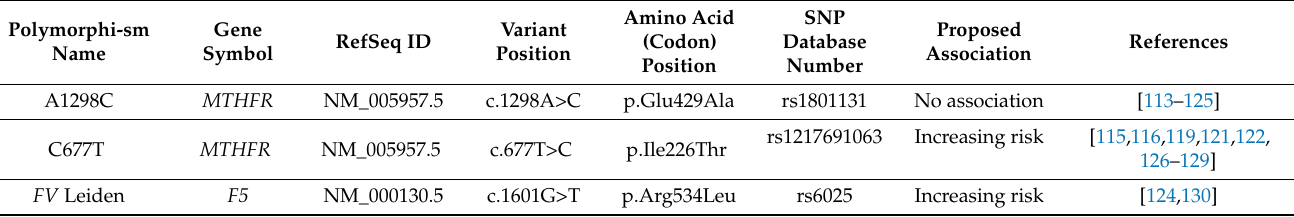
Table 2. Genetic risk factors most commonly studied in pediatric stroke.